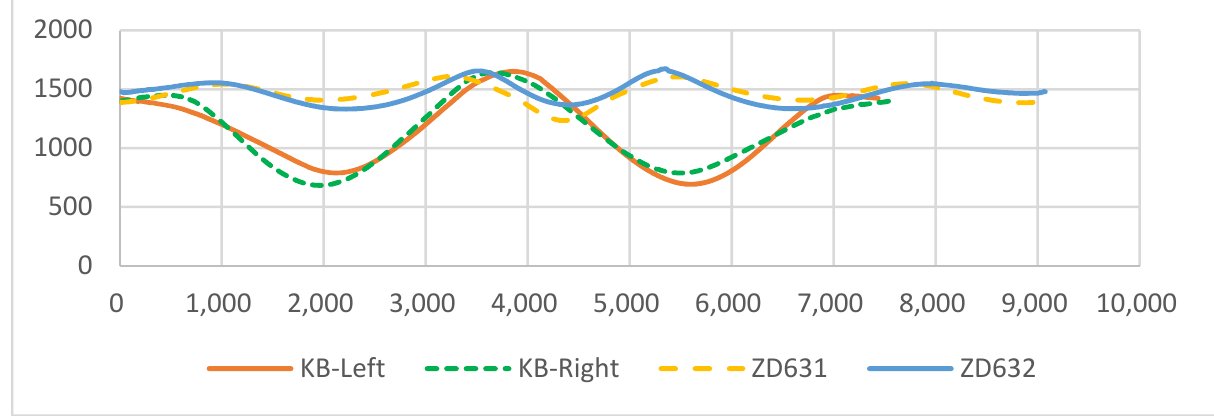
Figure 7. Sub-template workpiece contour curve.